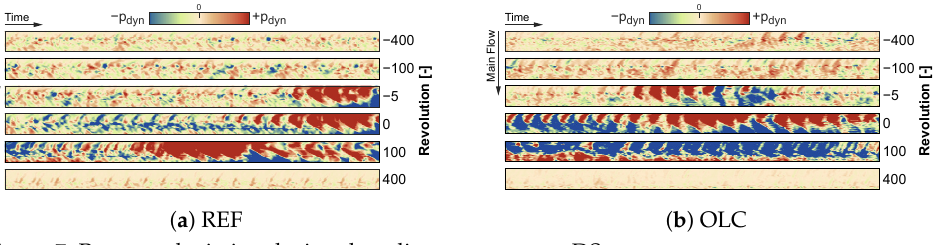
Figure 7. Pressure deviation during throttling maneuver at